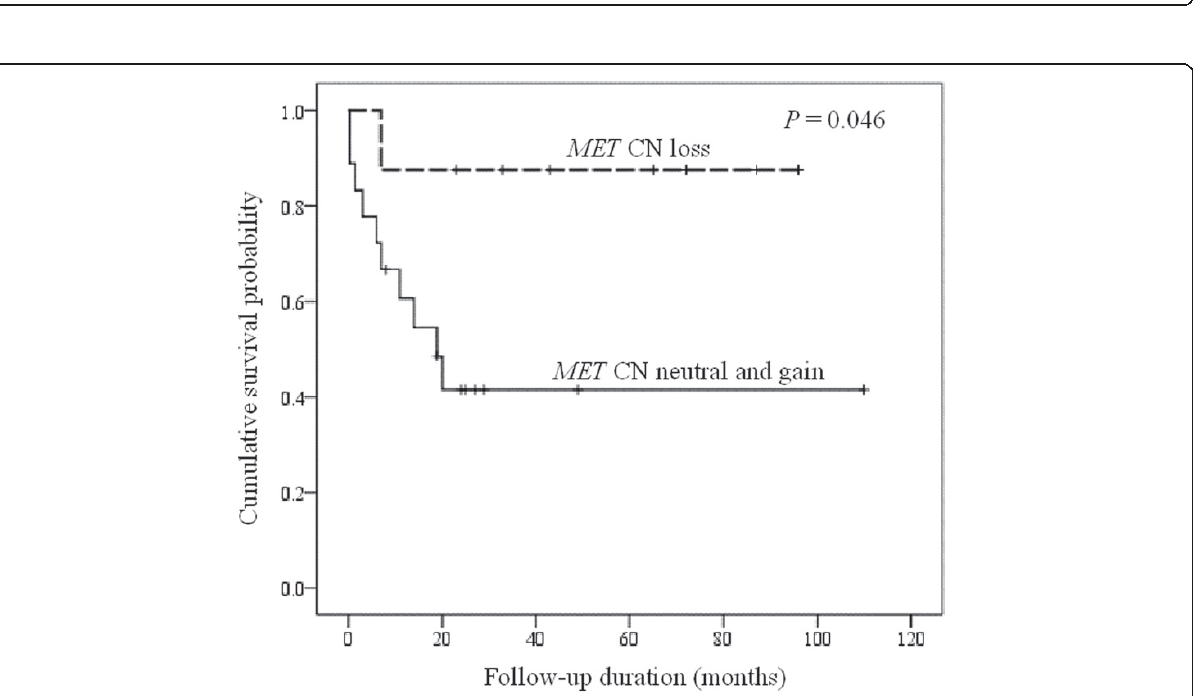
Figure 2 A representative case with MET copy number data analyzed by CopyCaller Software showing increased FAM to VIC ratio, indicating increased CN. Abbreviations: FAM, 6-carboxy-fluorescine-labeled MET probe; ROX (carboxy-X-rhodamine), internal reference dye used for normalization of fluorescent signal variations between wells; VIC: 4,7,2-trichloro-7-phenyl-6-carboxyfluorescein-labeled RNase P